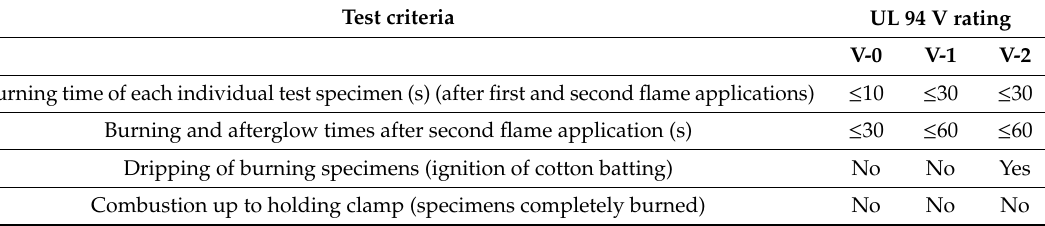
Table 2. Burning criteria for UL-94 vertical rating.